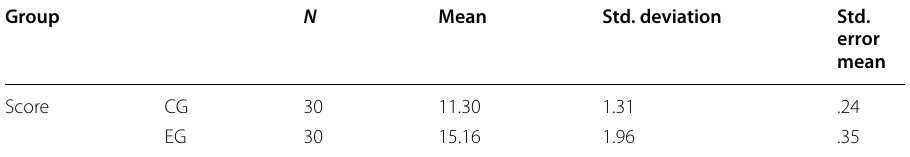
Table 8 Fluency post‑test descriptive statistics Group N